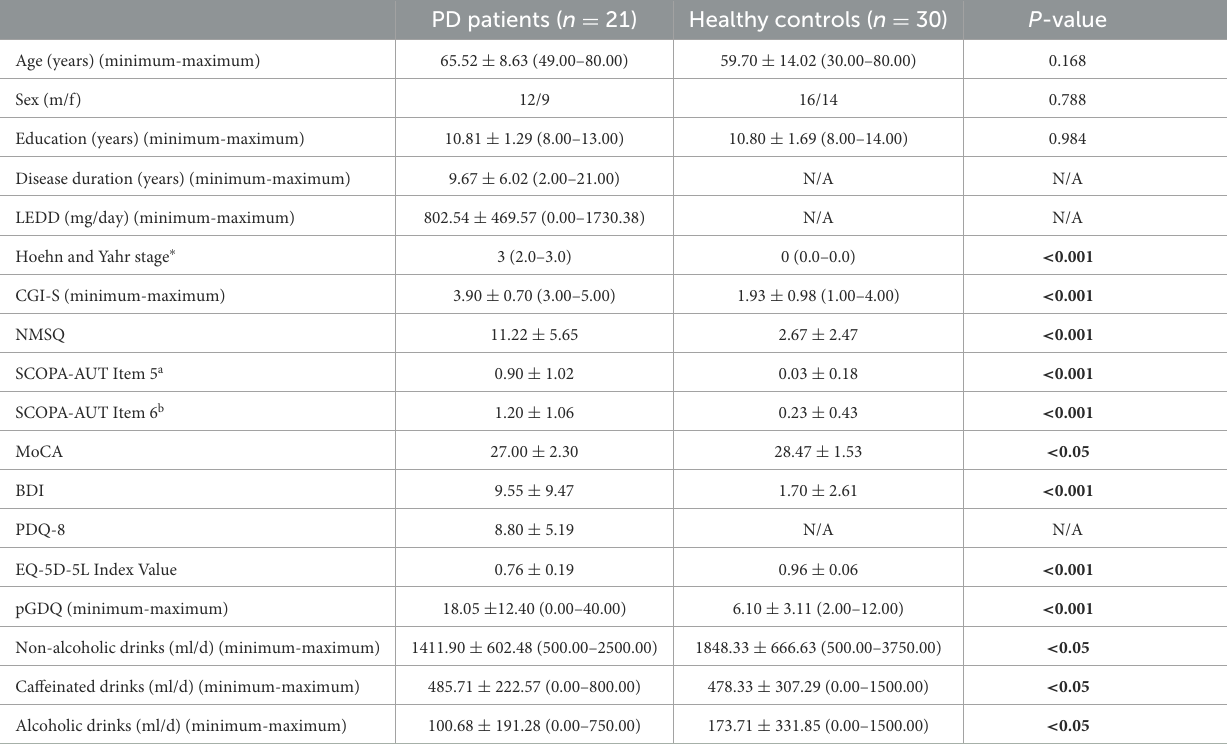
TABLE 1 Demographic, motor, and non-motor characteristics of patients with Parkinson’s disease (PD) and healthy controls of the phase 2a study. PD patients ( n = 21) Healthy controls ( n = 30) P